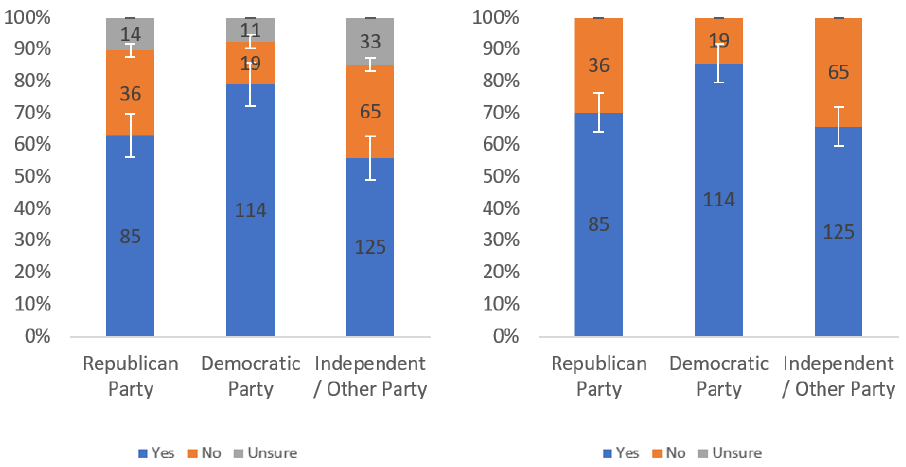
Figure A32. Responses regarding label helpfulness by party affiliation including ( left ) and excluding ( right ) unsure responses.